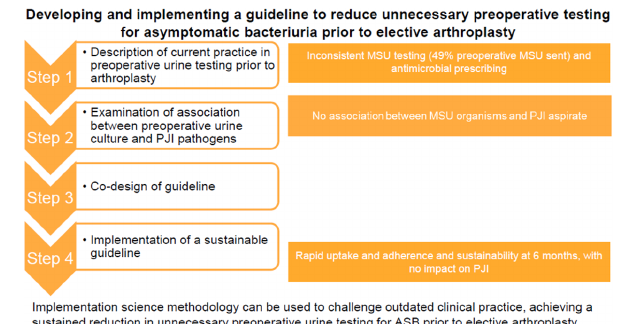
Figure 1. Graphic